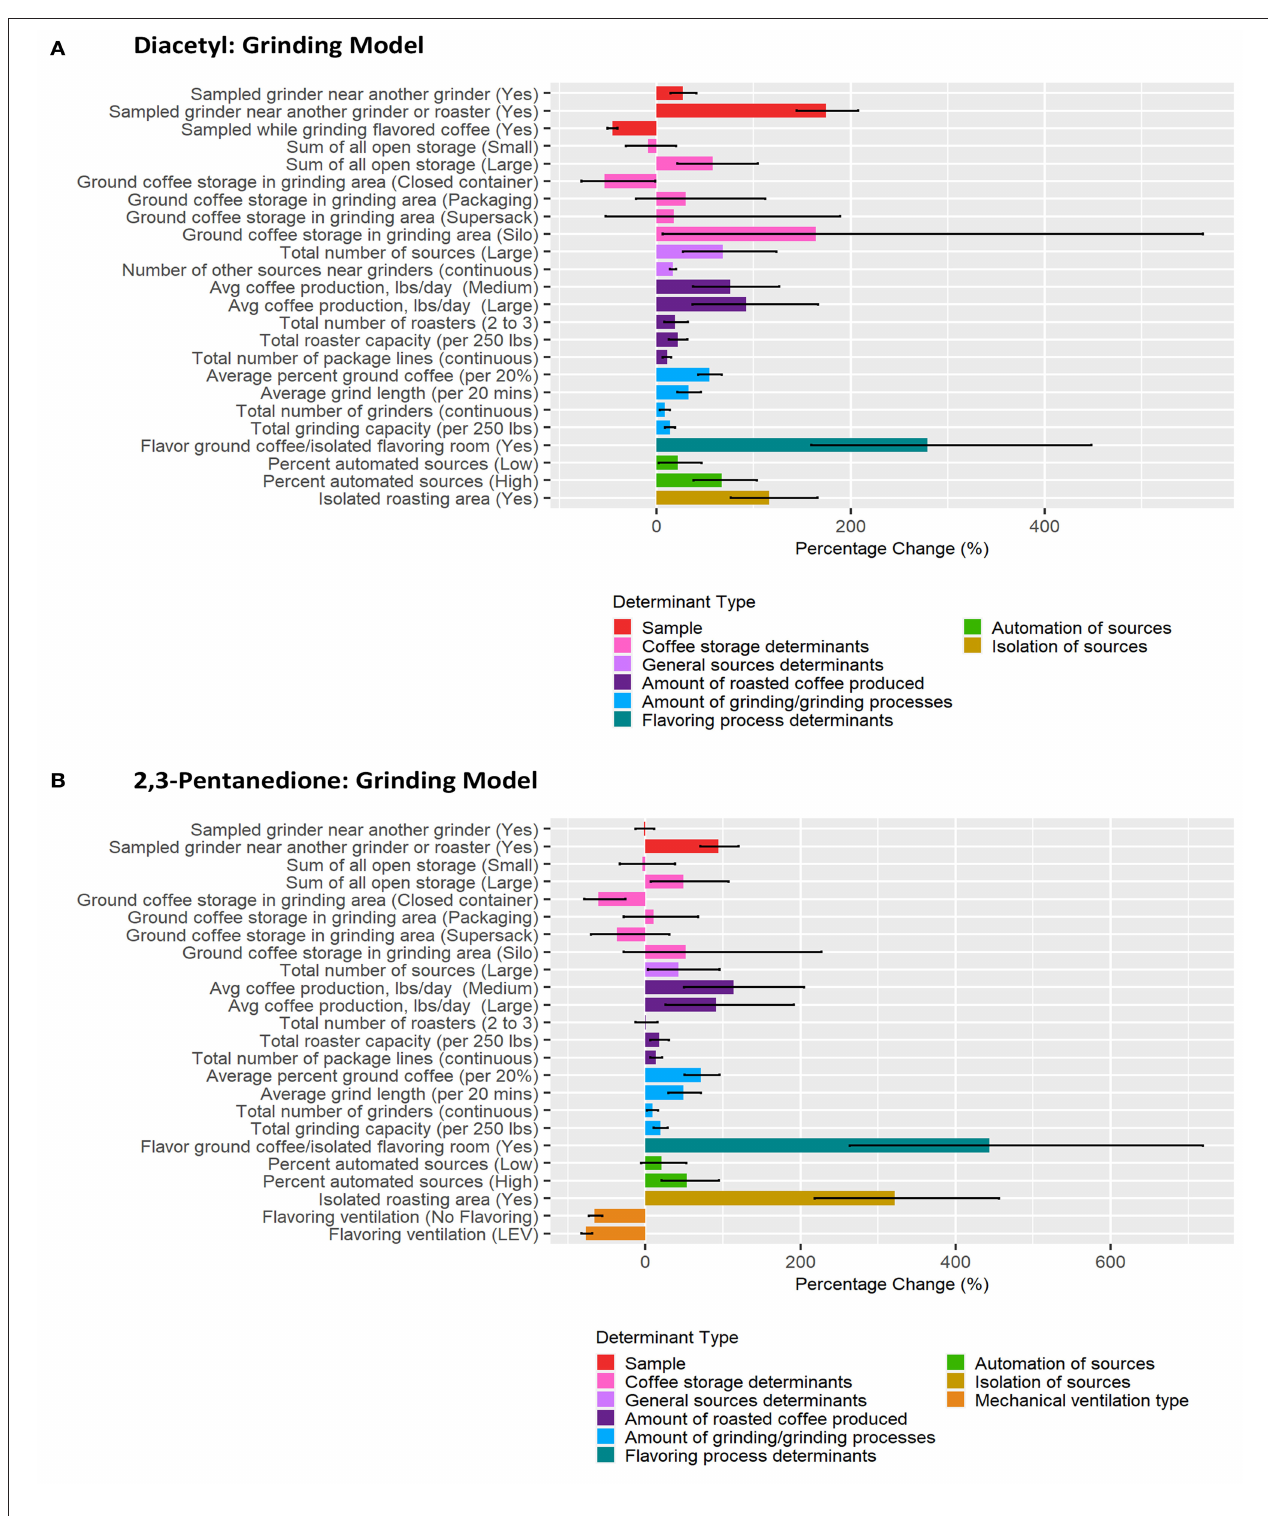
FIGURE 5 | Bar chart of percent change in diacetyl (A) and 2,3-pentanedione (B) exposures during grinding tasks compared with reference category or per unit change. Each bar represents the estimated percent change for the median posterior estimate with error bars for the 95% credible intervals. Percent change for continuous variables defined as per 1 unit with the exceptions of the following: total roaster capacity and total grinder capacity are calculated per 250 lbs, average percent ground coffee is calculated per increase in 20%, and average grind length in minutes is calculated per 20min.